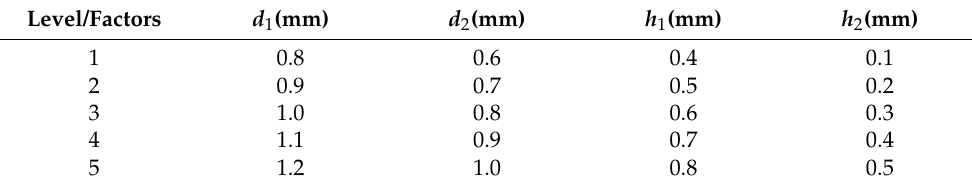
Table 4. Orthogonal factor level table.